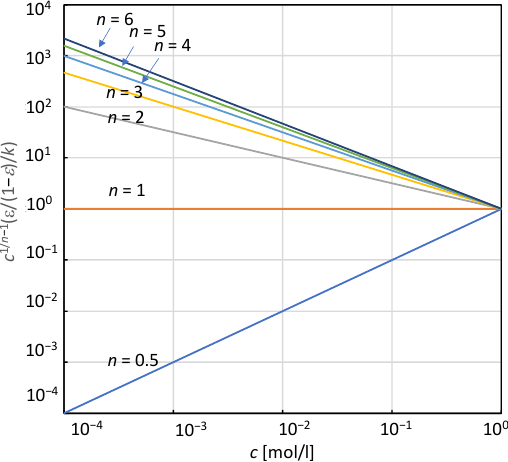
Figure 1. Distribution ratio of adsorbate.